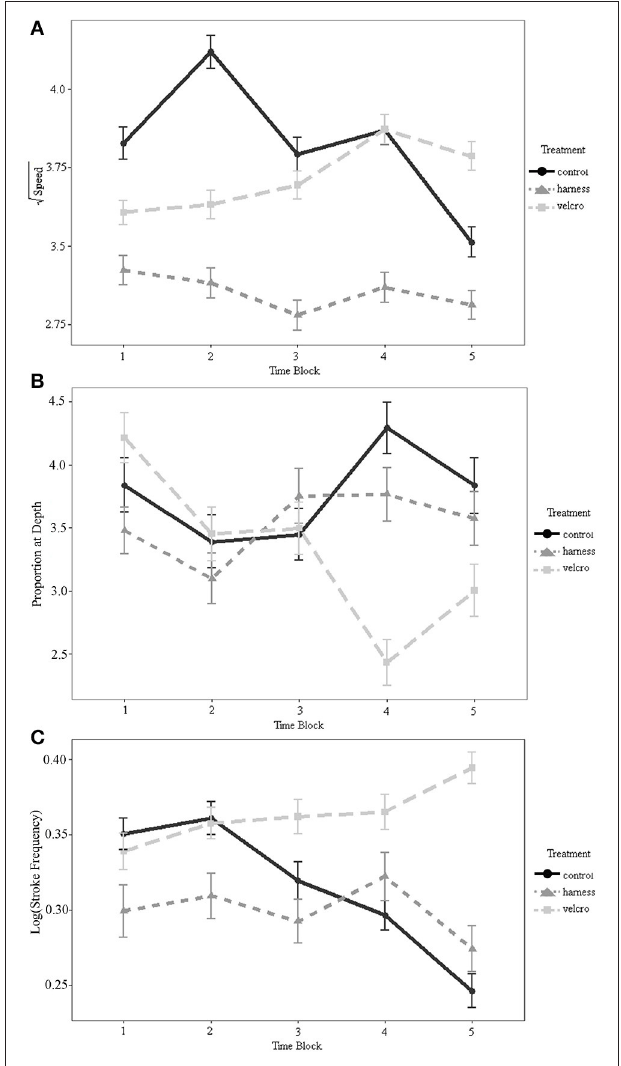
FIGURE 4 | (A) Interaction plot of the square-root transformed speed (cm/s) as a function of time for each treatment. (B) Interaction plot of the proportion of time spent below 15cm as a function of time for each treatment. (C) Interaction plot of the log transformed stroke frequency (Hz) as a function of time for each treatment. Minutes comprising the time periods are 1 = (0–5min), 2 = (5–10min), 3 = (10–15min), 4 = (15–20min), 5 = (20–25min). Error bars represent standard